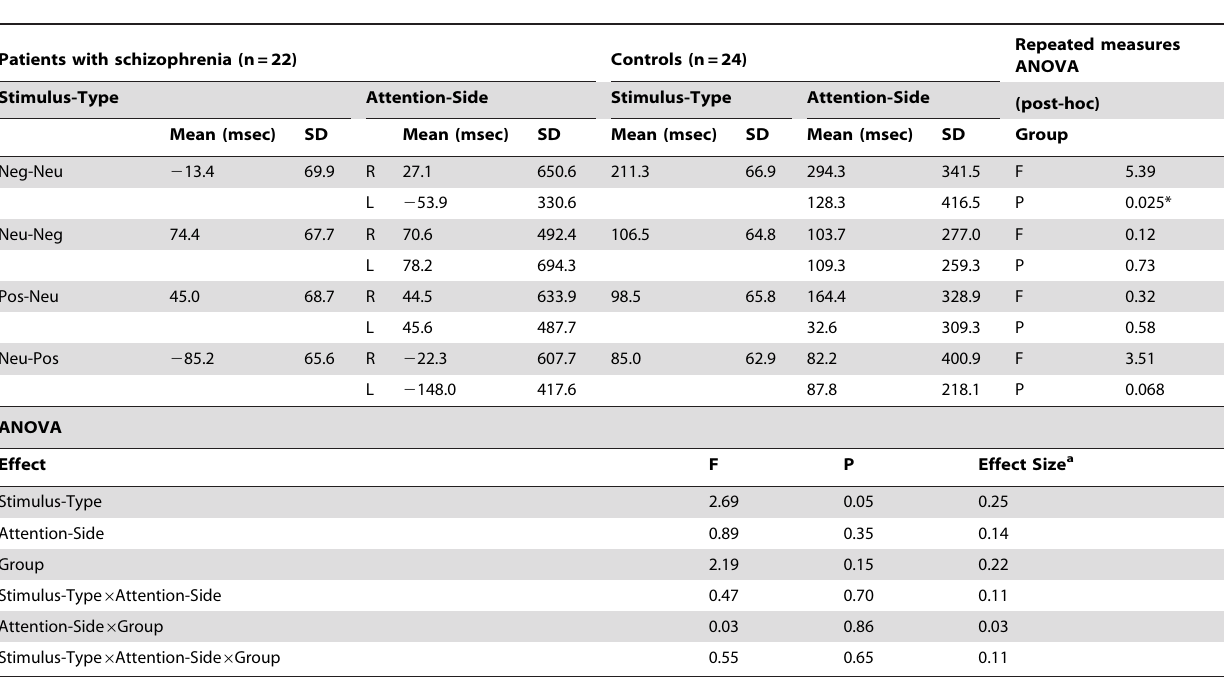
Table 3. Comparisons of Interference indices between the patients and controls.